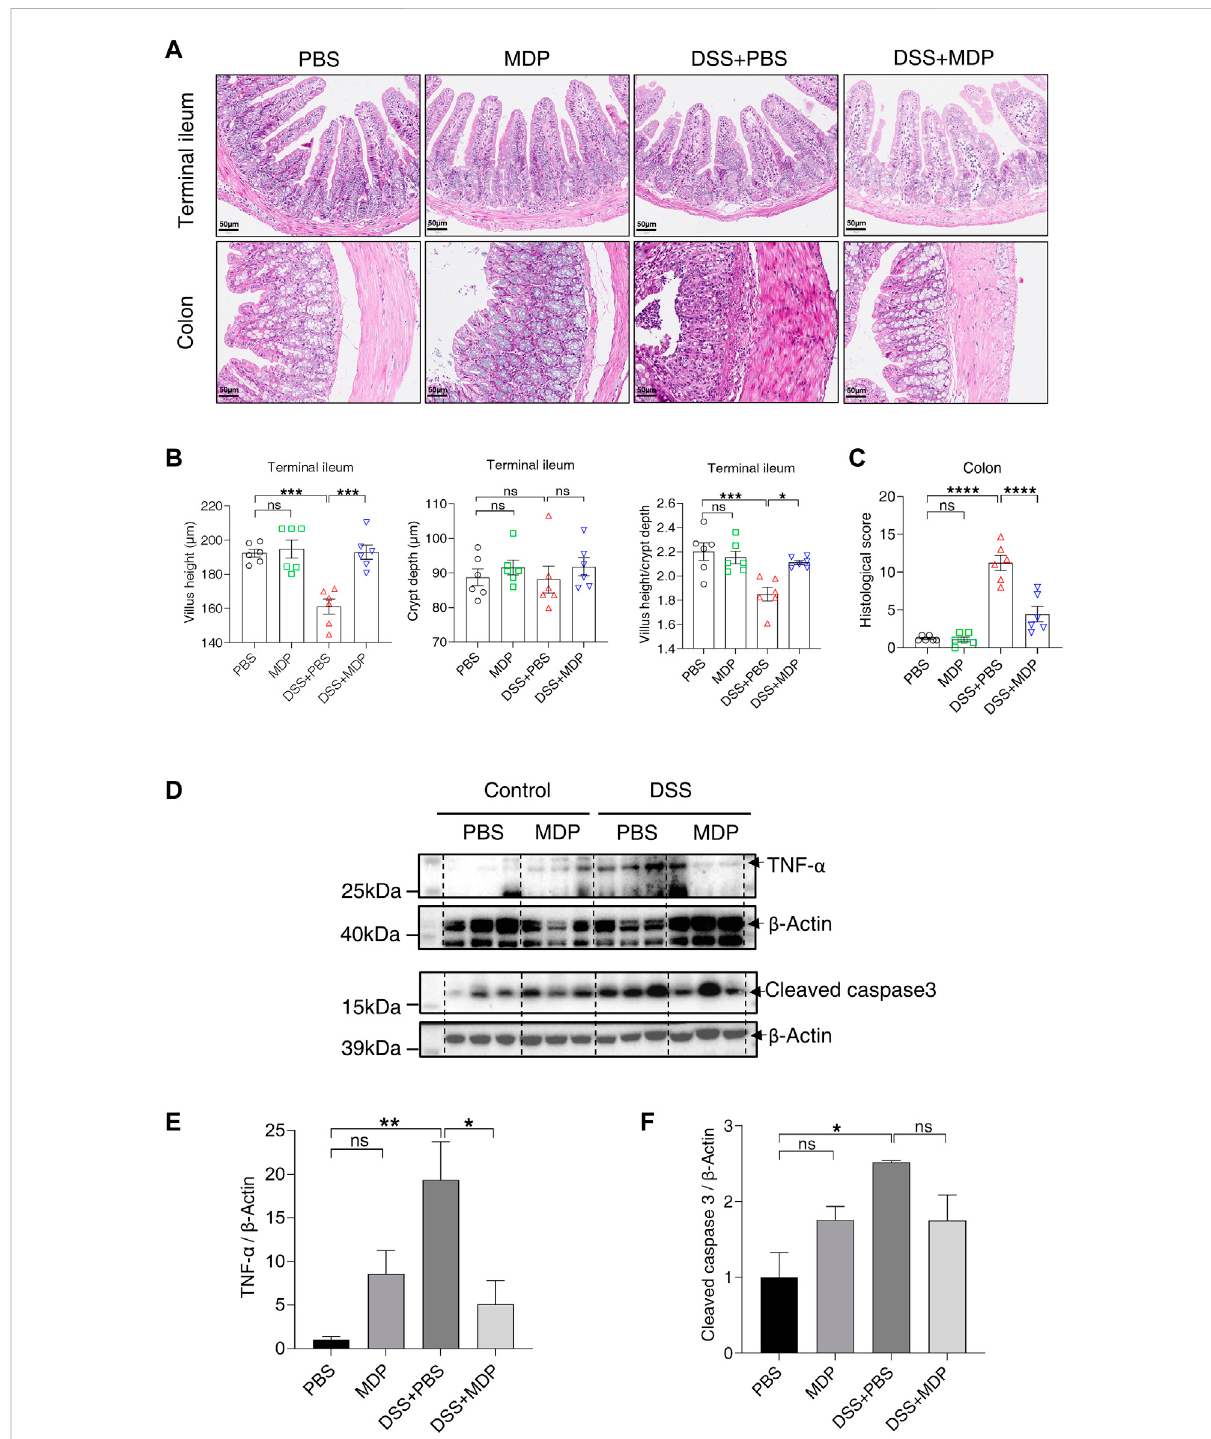
FIGURE 2 MDPinhibitsin fl ammatoryresponseintheintestine. (A) RepresentativeimagesofH&EstainingforterminalileumandcolontissuesinPBS,MDP, DSS + PBS, and DSS + MDP group mice (n = 6, each group), respectively. scale bars: 50 μ m. (B) Quanti fi cation of villus height, crypt depth, and the ratio of villus height and crypt depth in the terminal ileum (n = 6, each group). (C) The histological score of colons (n = 6, each group). (D) Western blottinganalysisforTNF- α andCleavedcaspase3with β -ActinastheinternalstandardproteinincolonofPBS,MDP,DSS+PBS,andDSS+MDP group mice. Representative images of three duplicate samples of the immune blotting were shown. (E,F) Quanti fi cation of the relative expression of TNF- α and Cleaved caspase 3 in panel (D) by ImageJ, respectively. Data were expressed as mean ± SEM. * p < 0.05, ** p < 0.01, *** p < 0.001, **** p < 0.0001, ns, not signi fi cant, One-way